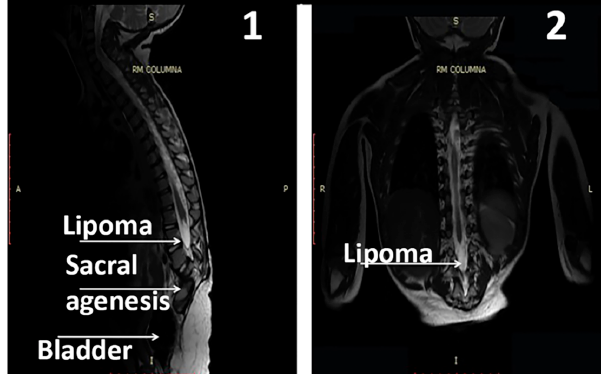
Figure 3. MRI performed at age 3-years old. ( 1 ) and ( 2 ) show sagittal and antero-posterior images (respectively) of the spinal cord. In 1, sacral agenesis and the hypoplastic L3 vertebra can be clearly seen (white arrow). In both images, a small lipoma can be seen in the lower part of the conus medullaris. As the images show, the SC was normal in its diameter and morphology, but a small hydrosyringomyelia can be seen. In ( 2 ) , an asymetry between the right and left hip can be observed. A: anterior; P: posterior; S: superior; I: inferior; R: right side; L: left side.